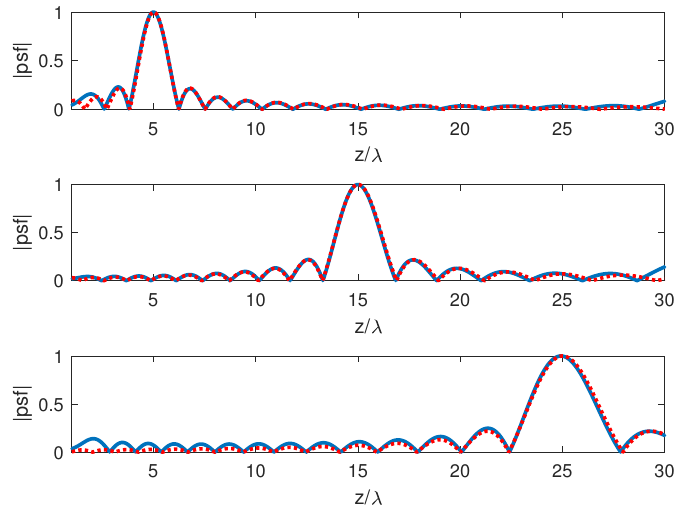
Figure 4. Magnitude of the point spread function for a = 30 λ , z 1 = λ and z 2 = 30 λ . The blue line is psf , while the dotted red line refers to psf h . In the top panel z (cid:48) is 5 λ , in the middle 15 λ and in the bottom 25 λ .